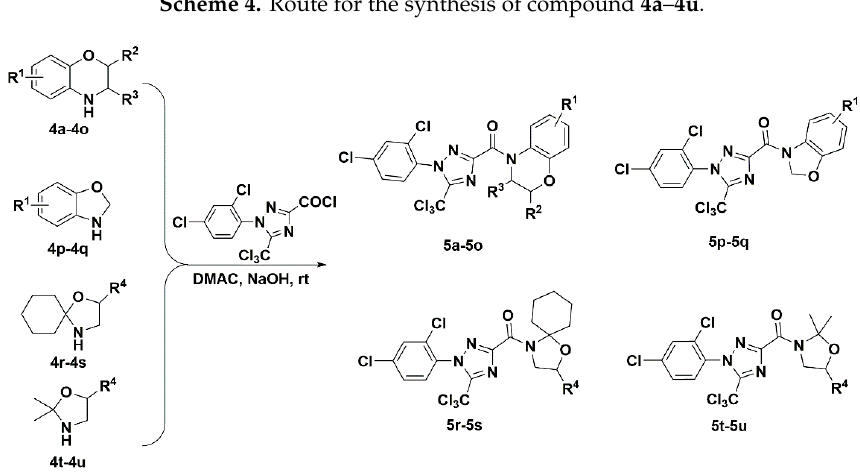
Scheme 4. Route for the synthesis of compound 4a – 4u .